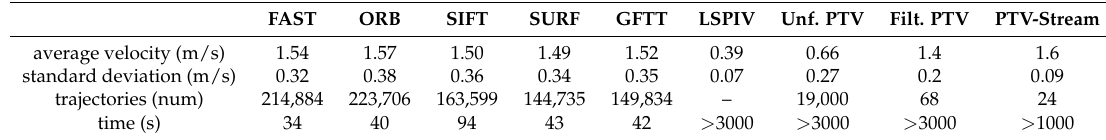
Table 3. Average velocity, standard deviation, number of trajectories, and processing time for the video on the Tiber River and the five different feature detectors, as well as all velocimetry approaches. The benchmark radar velocity was 2.33m/s. FAST ORB SIFT SURF GFTT LSPIV Unf. PTV Filt. PTV